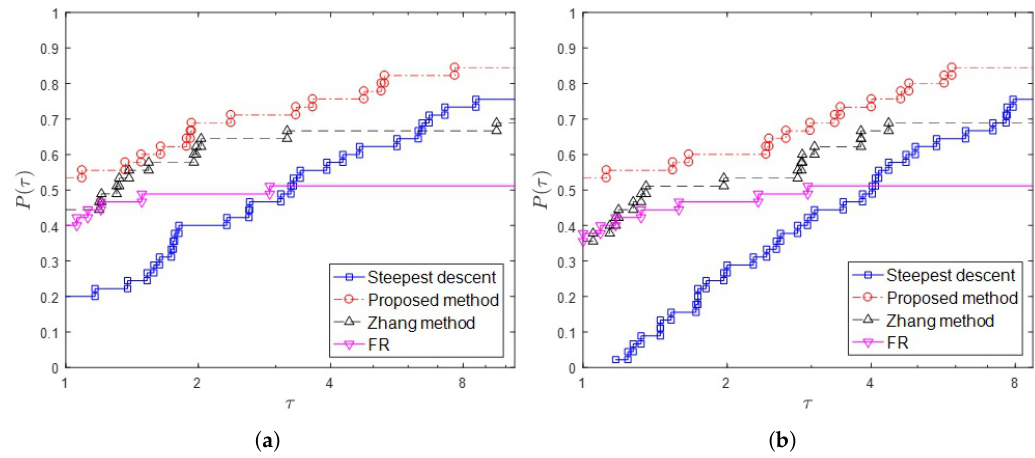
Figure 1. Performance profiles based on CPU time ( a ) and the number of iterations (NI) ( b ) for 45 functions in the Table 1.